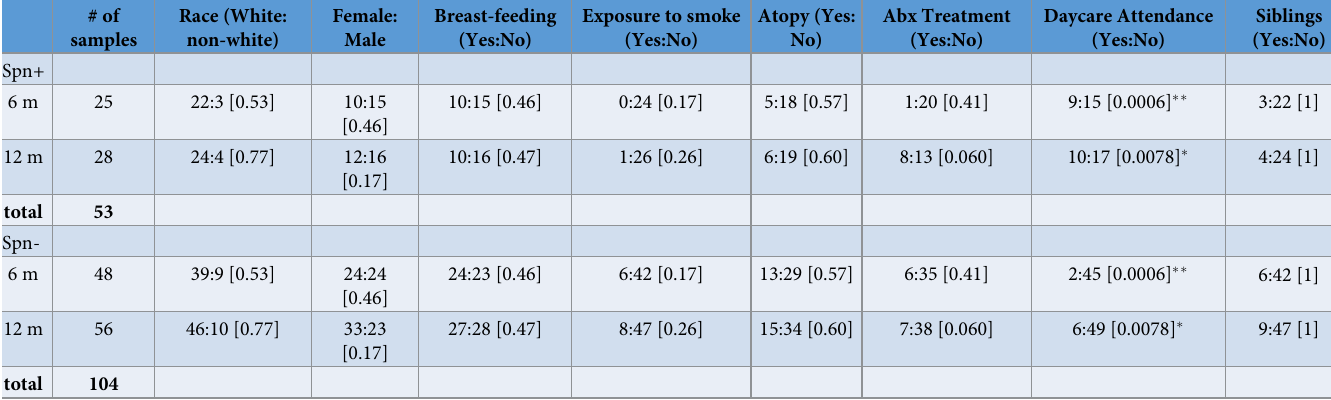
Table 1. Demographic factors associated with Spn colonization.